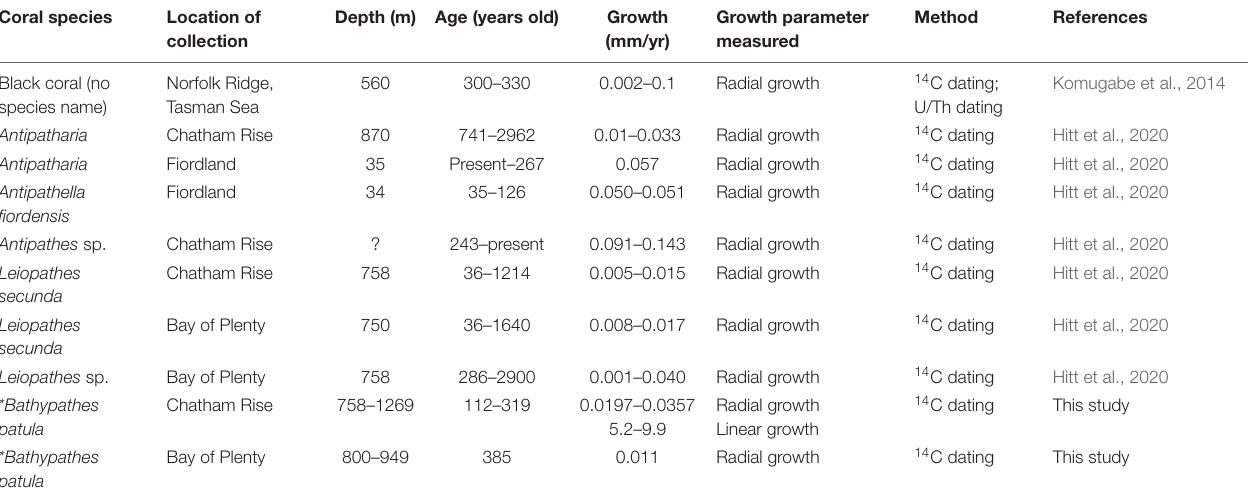
TABLE 5 | Radiocarbon age estimation studies on New Zealand black corals ( Antipatharia